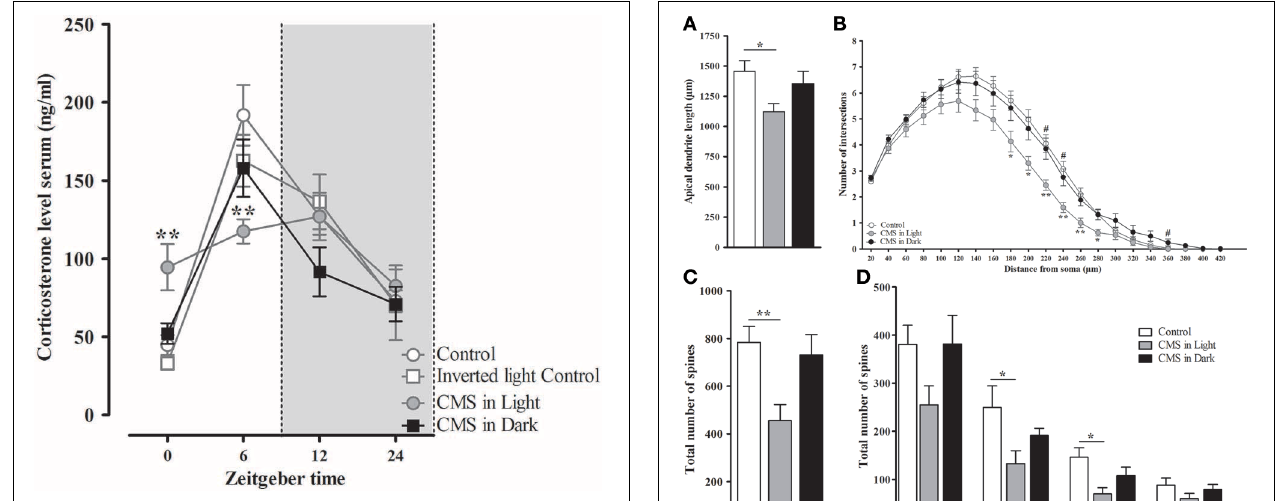
FIGURE 5 | Diurnal rhythm of corticosterone secretion in rats exposed to CMS in different phases of the day light-dark cycle. Serum corticosterone levels during 24h post CMS, measured every 6h. Controls, n = 20, each CMS group, n = 14; ∗∗ P < 0 . 01. Data presented as mean ± s.e.m. ∗∗ indicate significant differences between the CMS-Light and the CON group.